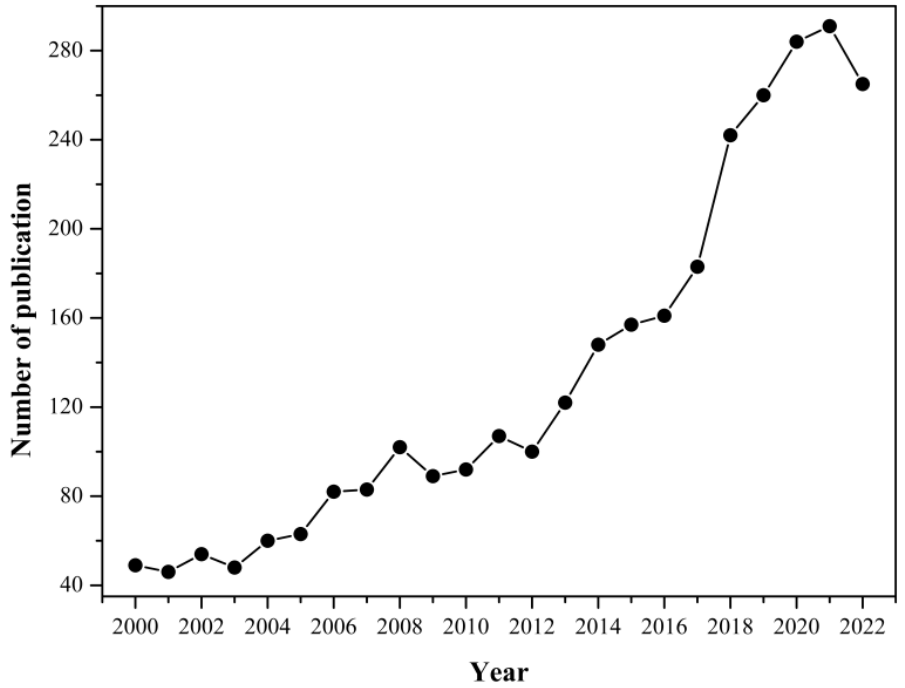
Figure 1. The growth of publications as a function of years for OFBS. Data from Web of Science.